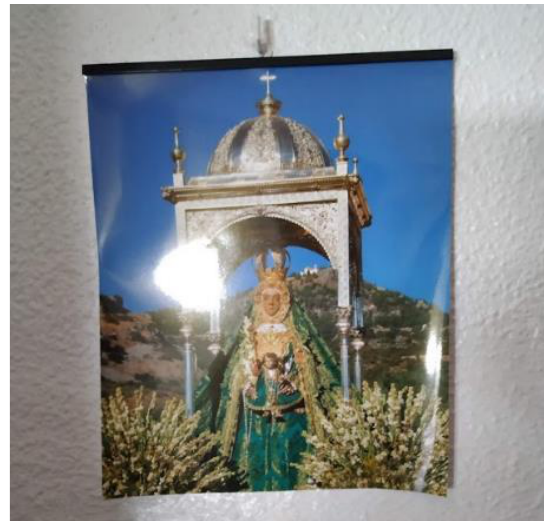
Photograph 6: Poster of Virgin Mary statue in front of Pueblo’s landscape, on the bedroom wall of a care home. Photograph taken by author. September,